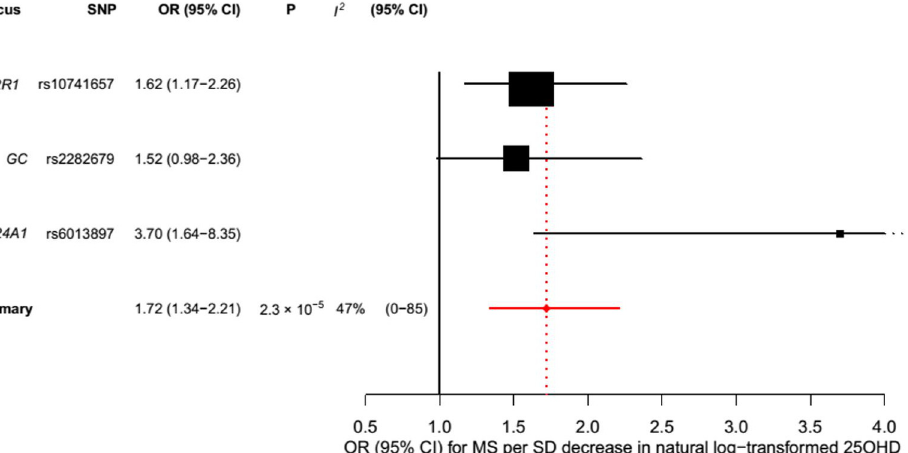
Fig 5. Mendelian randomization estimate of the association of 25OHD level with risk of multiple sclerosis excluding the DHCR7 locus. Estimates obtained using a fixed-effects